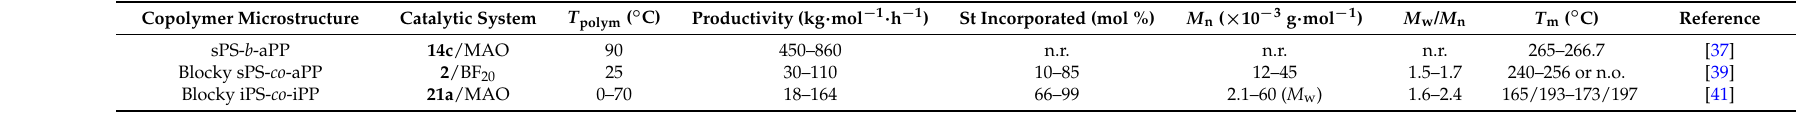
Table 2. Stereoregular styrene-propylene copolymers: catalytic system and polymer properties.